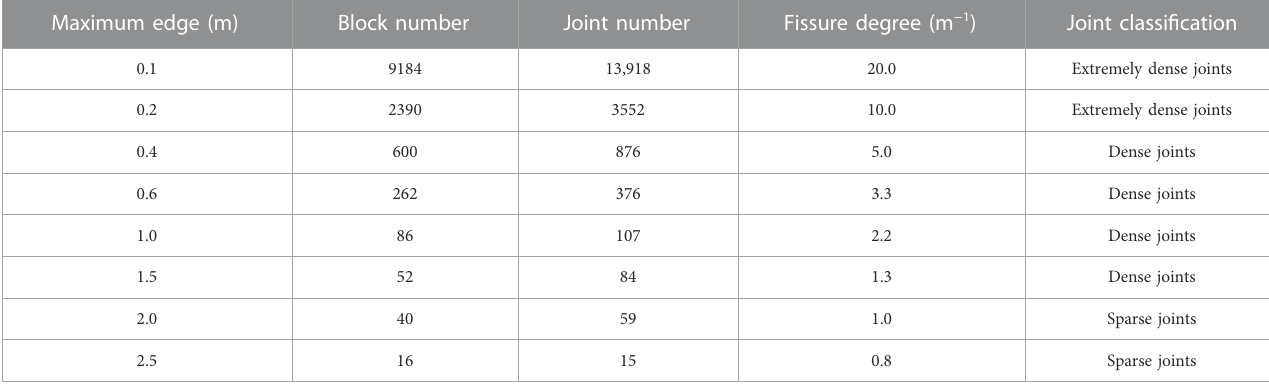
TABLE 6 In fl uence of the maximum edge length of the rigid block on the joint development characteristics. Maximum edge (m) Block number Joint number Fissure degree (m − 1